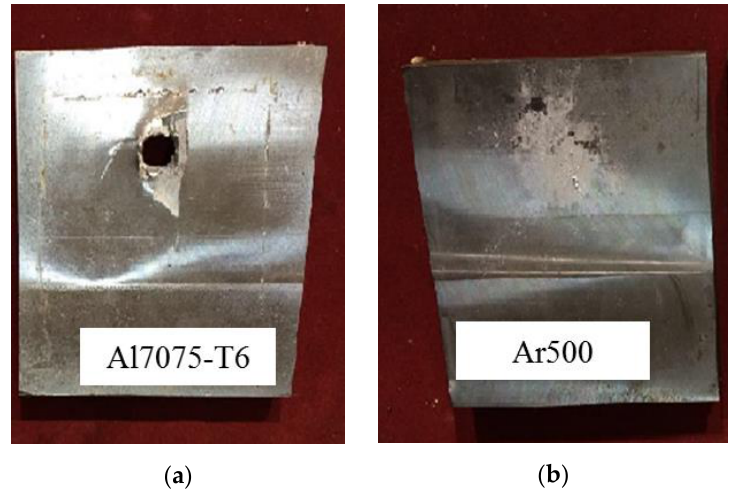
Figure 12. Final condition of plates constituting Configuration B panel: ( a ) front layer of Al7075-T6 alloy; and ( b ) back layer of Ar500 steel.